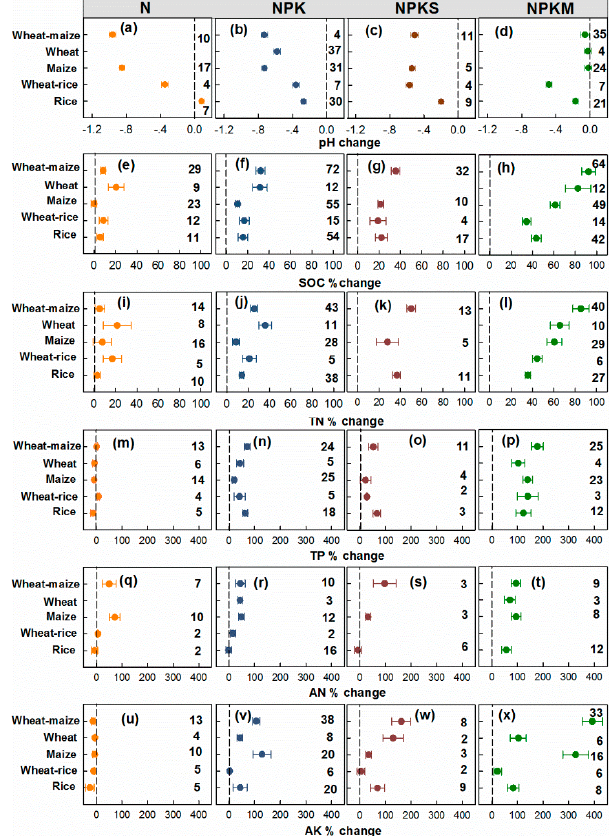
Figure 4. Effects of the crops (wheat − maize, wheat, maize, wheat − rice, rice) and fertilizer types (N, NPK (phosphorus, potassium and nitrogen), NPKS (NPK with straw returning), NPKM (NPK with manure)) on soil chemical properties (pH ( a – d ), SOC ( e – h ), TN ( i – l ), TP ( m – p ), AN ( q – t ), AK ( u – x )) (SOC: soil organic carbon. TN: total nitrogen. TP: total phosphorus. AN: alkali − hydrolysable nitrogen. AK: available potassium). Numbers of sampling data are on the right. Change and % change were compared to the control. Points and whiskers are mean values with the standard error.